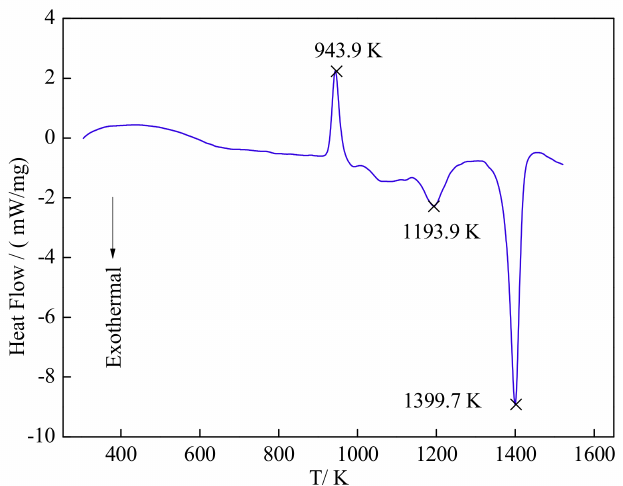
Figure 9. DSC curves of the Al-5Ti-0.62C system.